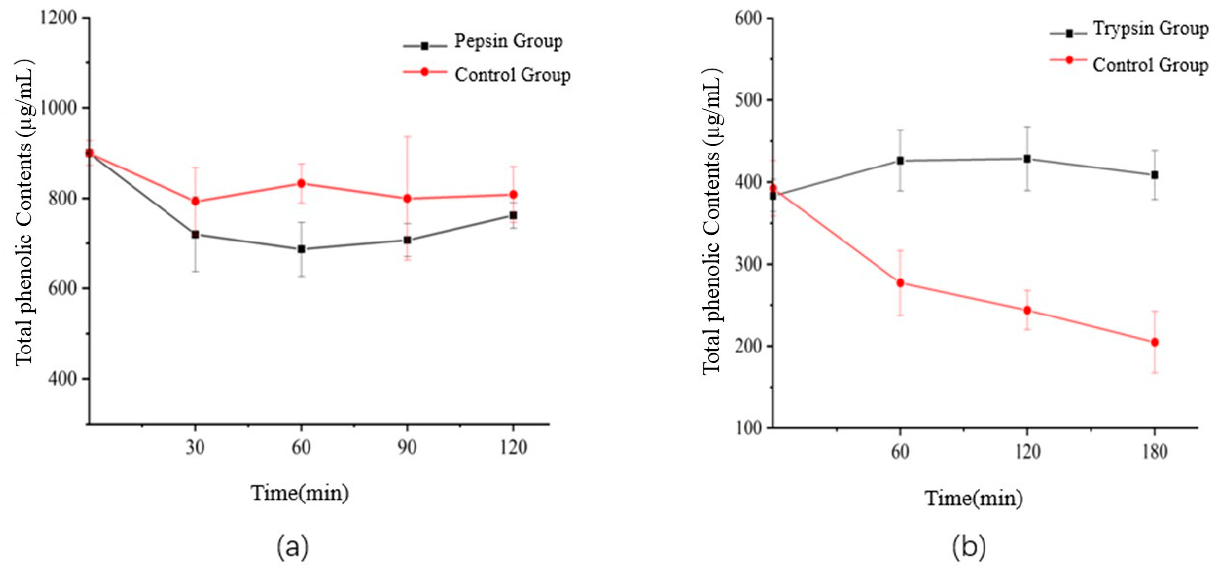
Figure 5. Changes of total phenols in simulated gastric ( a ) and intestinal ( b ) digestion of Semen Hoveniae in vitro